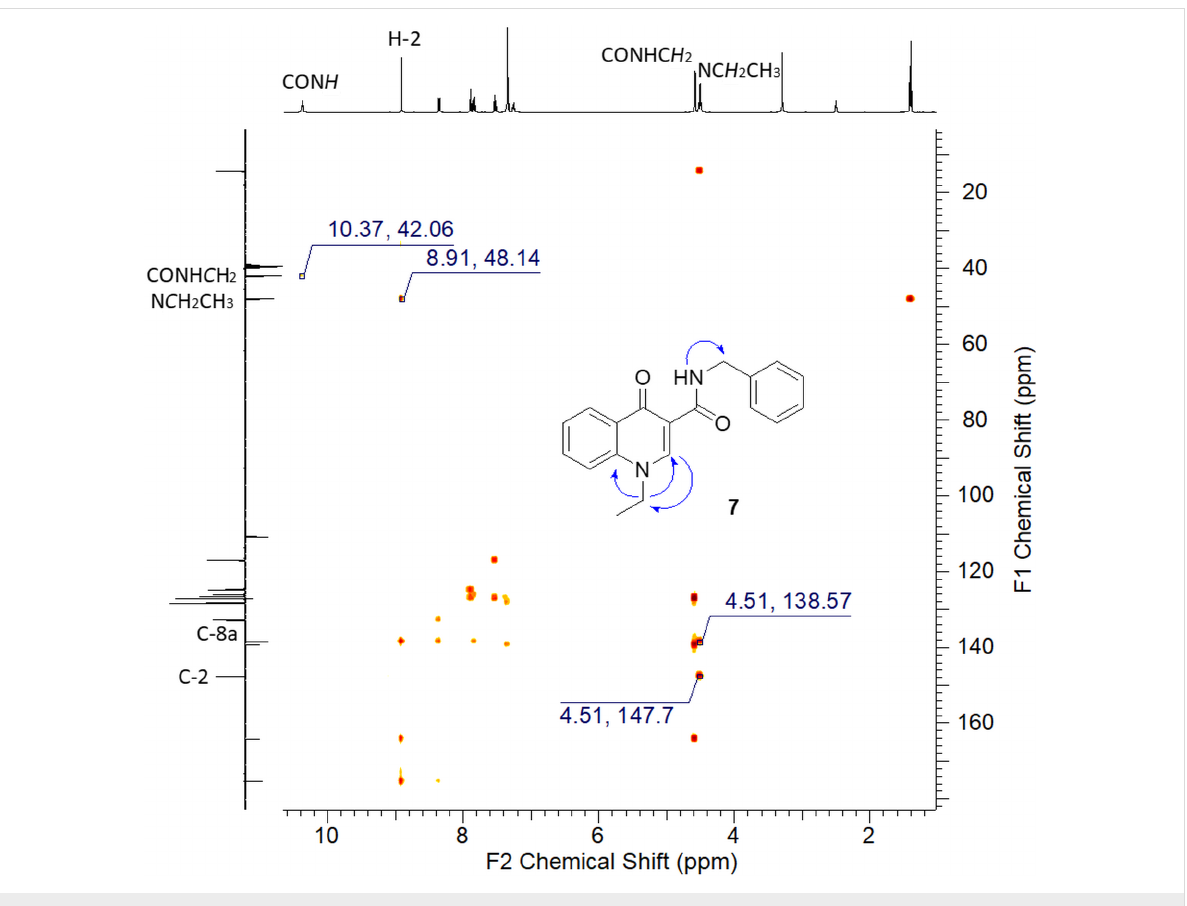
Figure 5: Partial HMBC spectrum of derivative 7 (DMSO- d 6 , 500 MHz).